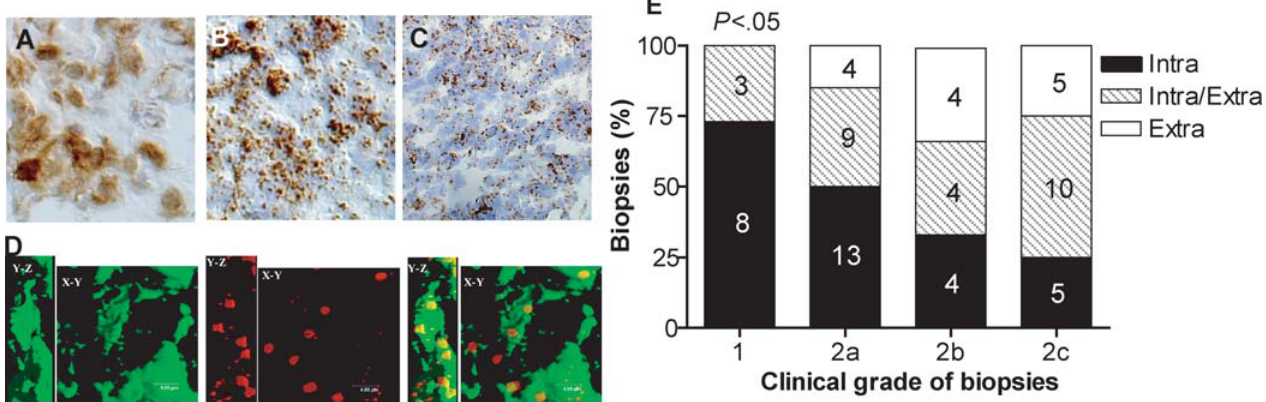
Figure 2. GAS Were Localized Extracellularly or Intracellularly in Phagocytic Cells in the Tissue Biopsies from patients with tissue infections ( n ¼ 70) caused by GAS were cryosectioned and immunostained for GAS. Immunohistochemical staining revealed three main staining patterns: (A) cytoplasmic, intracellular staining; (B) a combination of intra- and extracellular staining; and (C) extracellular staining. (D) Confocal microscopy of GAS (Alexa 546, red) and CD68-positive cells (Alexa 488, green) in the tissue. The figure shows a simulated fluorescence process projection of a sequential scan. The Y–Z area equals the vertical plane. Intracellular streptococci are shown in yellow. (E) Bacterial localization in relation to clinical grade. Tissue biopsies from patients with tissue infections caused by GAS were classified according to clinical grade (for definitions, see Methods). Numerals within bars denote number of biopsies. Statistical difference between groups was analyzed using Fisher’s